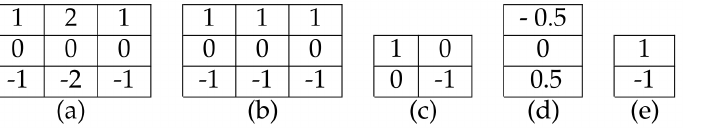
Figure 2. Different Gradient masks: ( a ) Sobel, ( b ) Prewitt, ( c ) Roberts, ( d ) Central difference, and ( e ) Intermediate